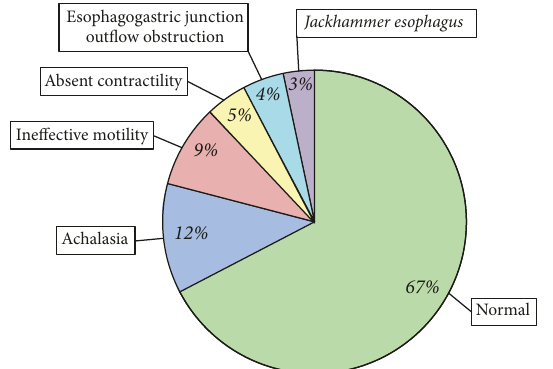
Figure 2: The manometric diagnosis of the 1099 high-resolution manometry studies performed at our tertiary motility center during thestudyperiodofthreeyears(January2015toDecember2017). The percentages indicate the proportion of all patients diagnosed with the associated esophageal motility